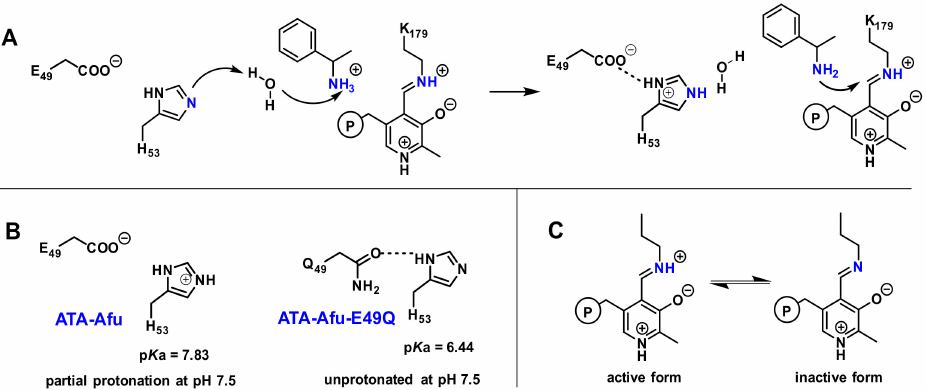
Figure 5. Postulated mechanism for the altered pH optimum of the E49Q variant of ATA-Afu. ( A ) H53 and E49 mediate the deprotonation of the substrate’s amino group. ( B ) The p K a value of the imidazole group of residue H53 is lowered by the E49Q substitution. ( C ) Internal aldimine of the PLP-cofactor. The negative charge is presumably stabilized by the neighboring residue